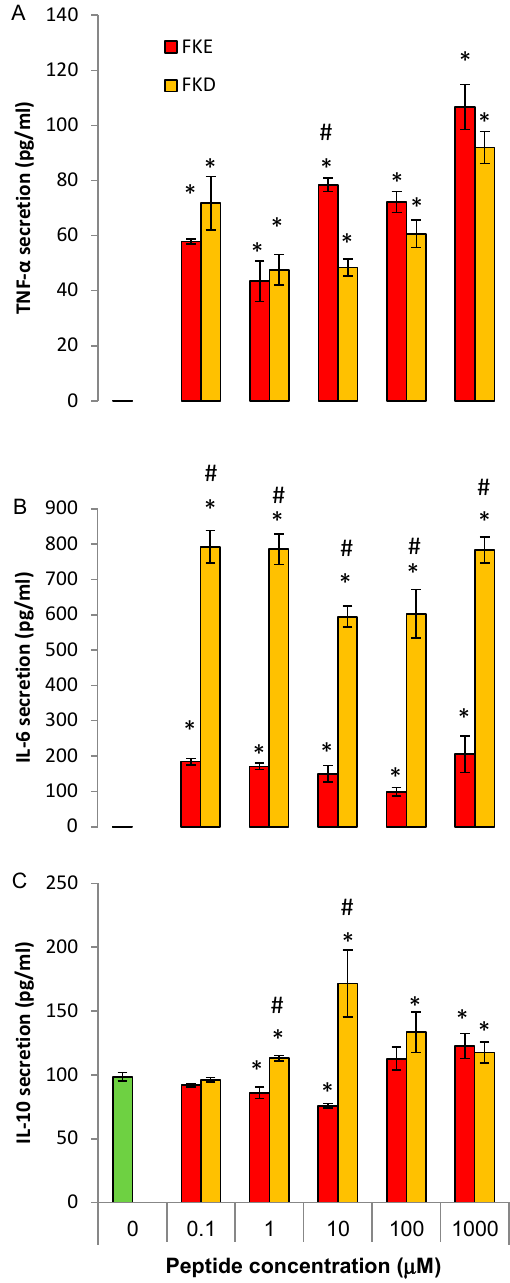
Figure 4. Lf-derived peptides regulate cytokine secretion from human macrophages. U937-derived macrophages were treated with FKE or FKD peptides (0.1–1000 µ M) for 24 h. Then, culture media was collected and its cytokine content was determined by standard ELISA for TNF- α ( A ), IL-6 ( B ), or IL-10 ( C ). Results are representative from five experiments and presented as mean ± SD with biological and analytical duplicates for each treatment. * and # indicate p < 0.05 compared to treatment with vehicle or with other peptide, respectively.